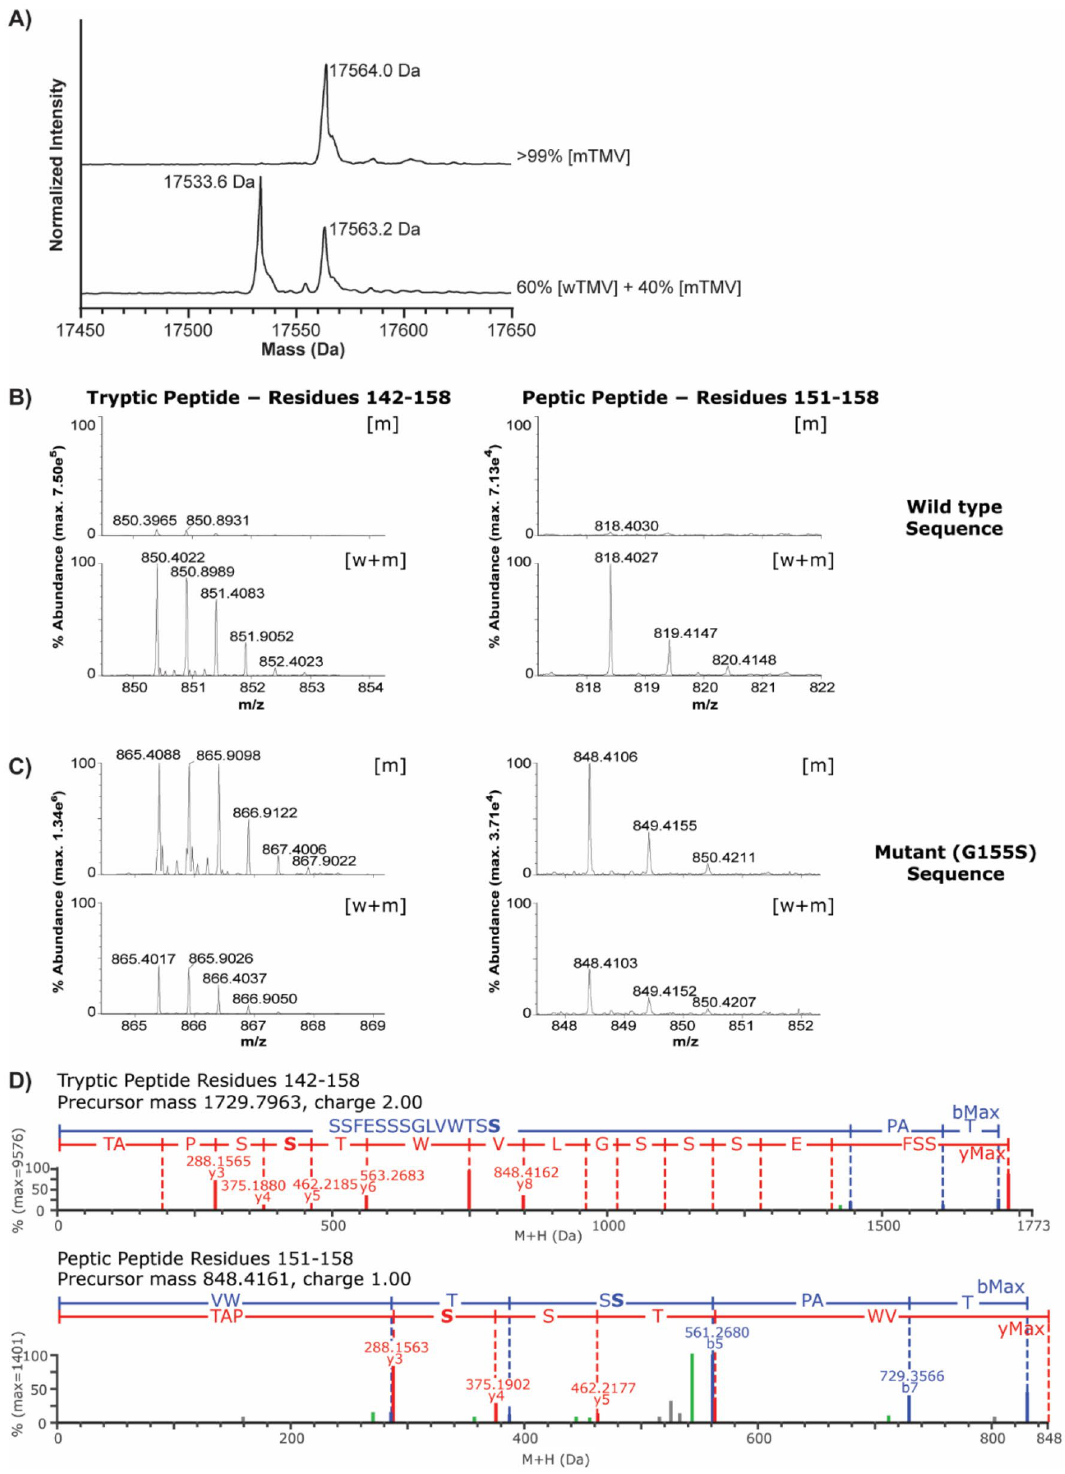
Figure 2. (A) Deconvoluted ESI–MS data of denatured TMV samples showing distribution between wTMV and mTMV. One sample contains 60% wTMV and 40% mTMV, while the other sample is almost entirely mTMV. (B) Peptide spectra recovered using the wild-type coat protein sequence. Peptide 142–158 (left) comes from a tryptic digest. Peptide 151–158 (right) comes from a peptic digest. Both peptides are reduced in the mTMV sample compared to the mixture of wTMV and mTMV. (C) Peptide spectra recovered using coat protein sequence containing S at position 155. Both peptides are more abundant in the mTMV sample compared to the mixture of wTMV and mTMV. (D) Fragmentation data for C-terminal peptides from the mTMV digests (top is trypsin; bottom is pepsin) when data was searched using a coat protein sequence containing the G155S